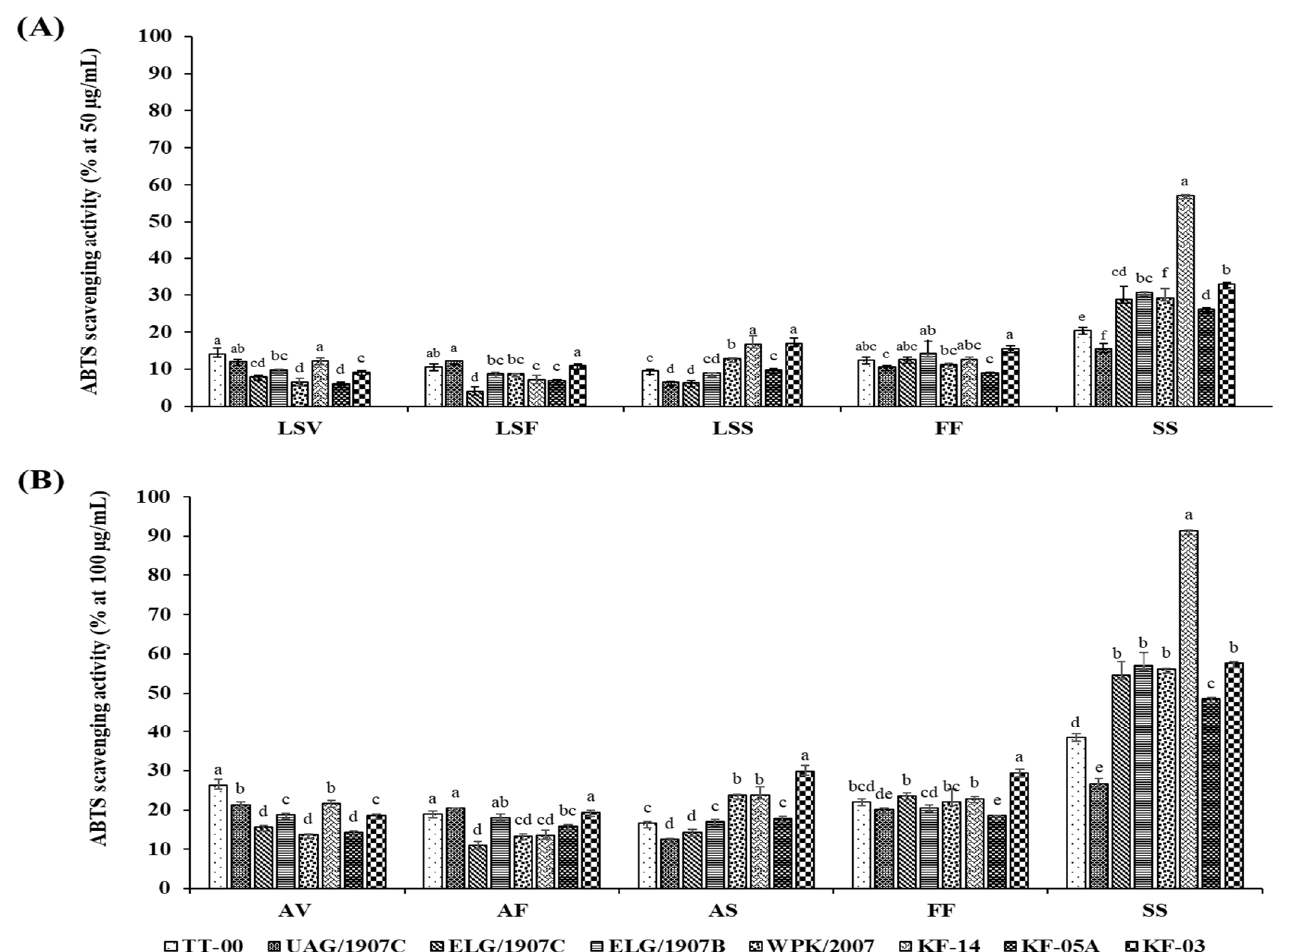
Figure 3. Dose-dependent ( A , B ) ABTS • + radical scavenging activity of extracts from 8 accessions of CG organs collected at various stages. Columns with the different letters for each specific organ are significantly different ( p < 0.05). LSV = leaves and stem in the vegetative stage; LSF = leaves and stem in the flowering stage; LSS = leaves and stem in the seed set stage; FF = flower part in the flowering stage; SS = silique part in the seed set stage Ability to scavenge free radicals expressed as RC 50 values of CG accessions different organ extracts obtained at different growth stages.